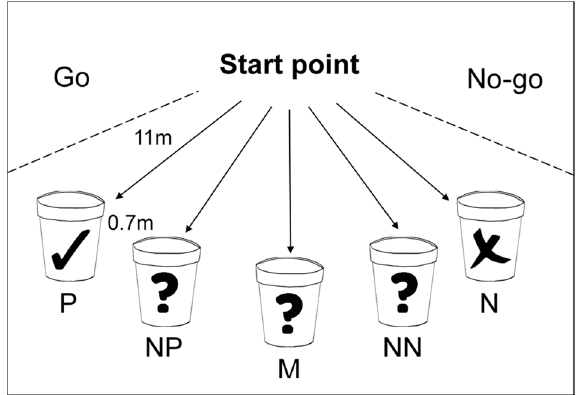
Figure 1. Diagram of the experimental setup, illustrating the five bucket locations (positive, P; near-positive, NP; middle, M; near-negative, NN; negative, N) and trained responses (Go, No-go).